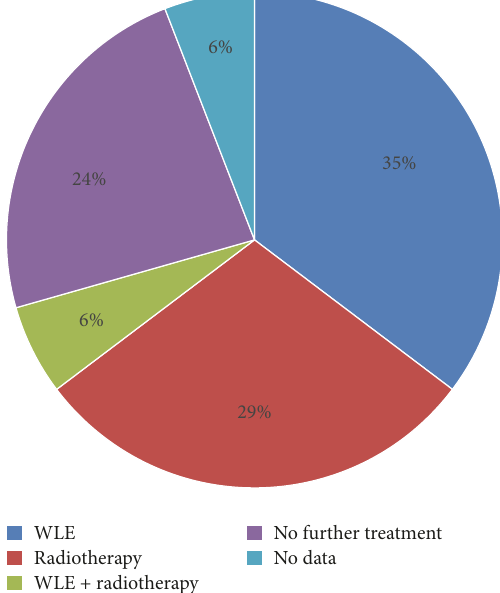
Figure 2: Follow-up and further treatment amongst patients with inadequately excised BCCs were heterogenous and